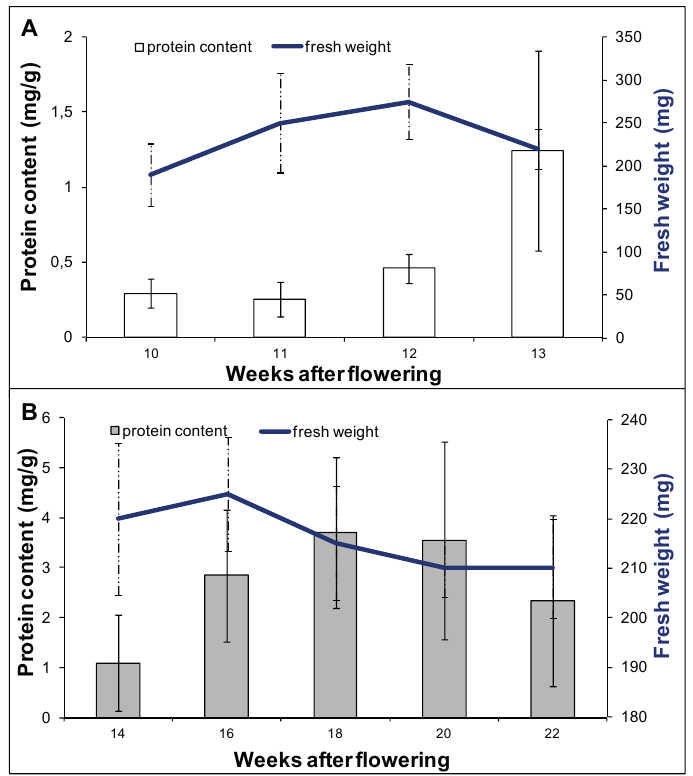
Figure 2. Protein content (columns) and fresh weight (line) of embryos of A. platanoides L. during morphogenesis: ( A ) 10 through 13 weeks after flowering (WAF) and maturation; ( B ) 14–22 WAF. Error bars represent SD ( n = 3).